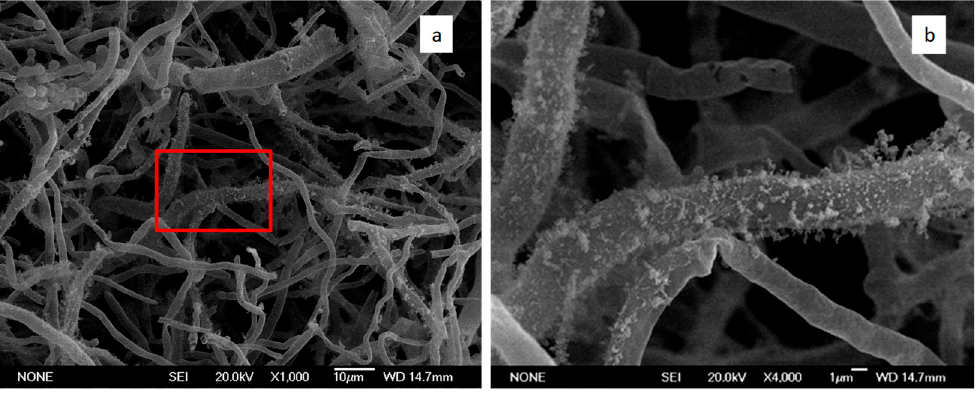
Figure 5. Scanning Electron Microscopy (SEM) images of ( a ) A.niger grown with turquoise after 14 days; ( b ) detail of precipitates on fungal biomass.